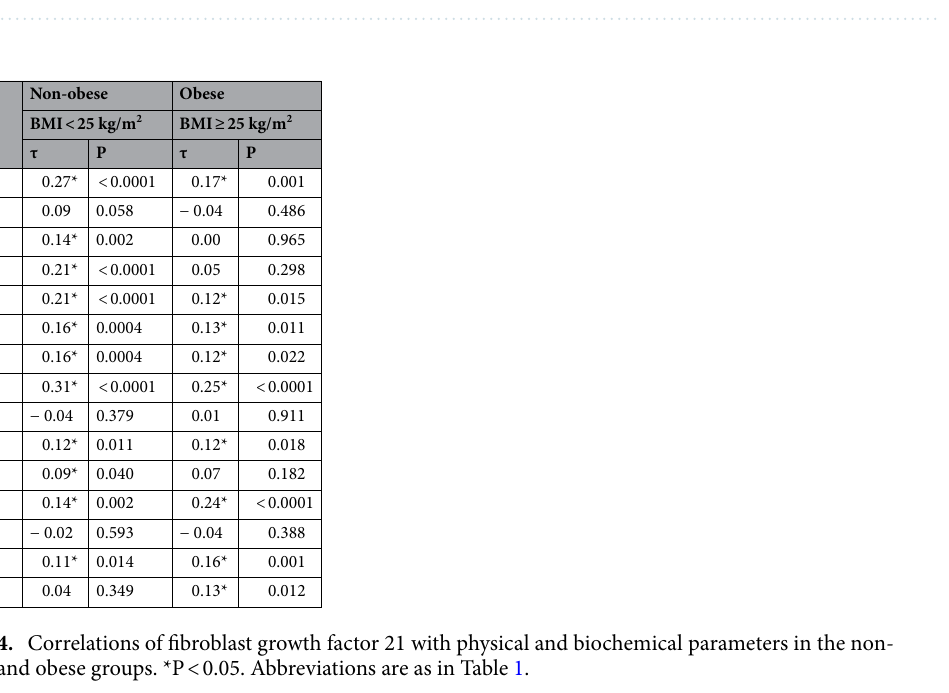
Table 3. Multivariable regression analysis of log-transformed fibroblast growth factor 21. *P < 0.05. Abbreviations are as in Table 1.